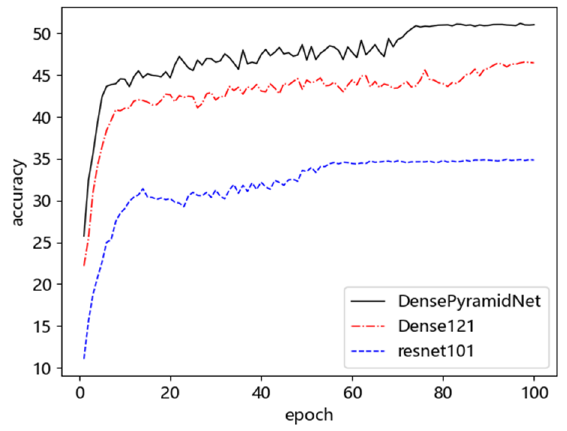
Figure 10. Test results of three algorithms on the cifar10.